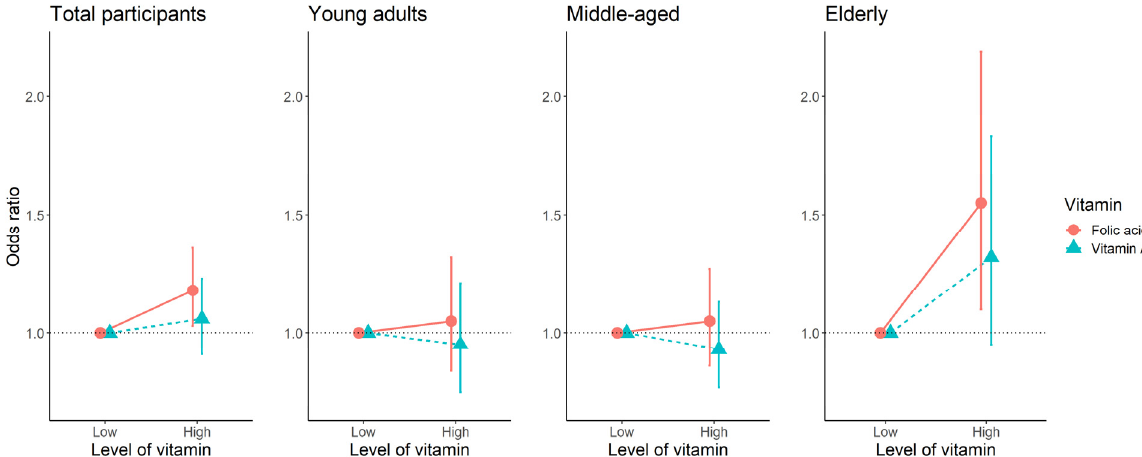
Figure 2. The association between binary variables of vitamin A and folic acid, and handgrip strength using logistic regression adjusted for covariates. Vitamin A: low (<0.52 mg/L), high ( ≥ 0.52 mg/L) in total participants; low (<0.47 mg/L), high ( ≥ 0.47 mg/L) in young adults; low (<0.54 mg/L), high ( ≥ 0.54 mg/L) in middle-aged; low (<0.53 mg/L), high ( ≥ 0.53 mg/L) in the elderly. Folic acid: low (<7.37 ng/mL), high ( ≥ 7.37 ng/mL) in total participants; low (<6.47 ng/mL), high ( ≥ 6.47 ng/mL) in young adults; low (<7.77 ng/mL), high ( ≥ 7.77 ng/mL) in middle-aged; low (<7.88 ng/mL), high ( ≥ 7.88 ng/mL) in the elderly. Higher handgrip strength: male ≥ 37.55 kg and female ≥ 22 kg in total participants; male ≥ 40.16 kg and female ≥ 23.43 kg in young adults; male ≥ 39.78 kg and female ≥ 22.62 kg in middle-aged; male ≥ 30.72 kg and female ≥ 17.86 kg in the elderly.